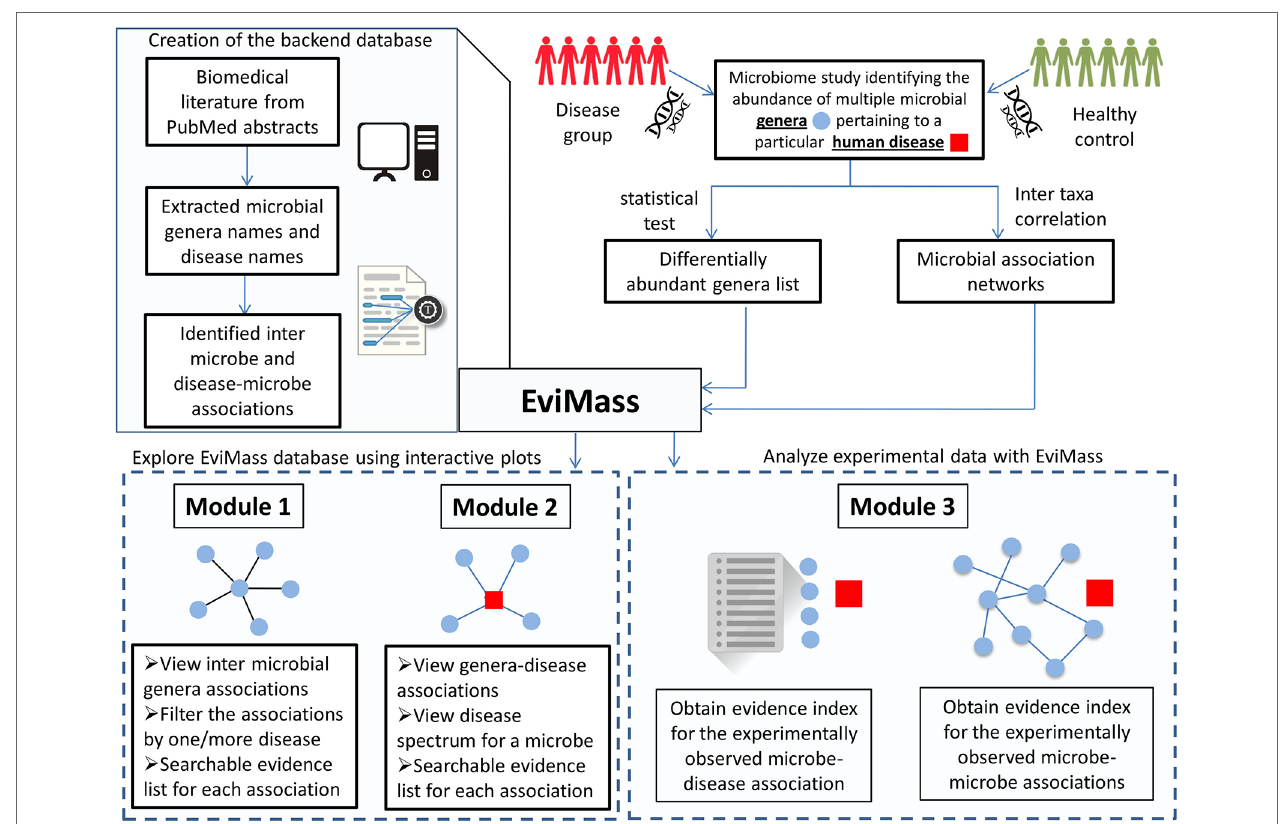
FIGURE 1 | Overview of the EviMass backend creation and utility of its various modules in understanding the intermicrobial and microbe–disease